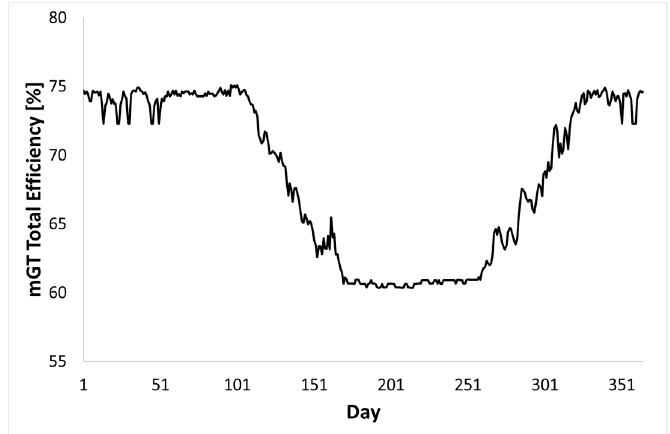
Figure 11. The recovery efficiency of the system (upgrader size of 180 Nm 3 /h). Energies 2019 , 12 , x FOR PEER REVIEW